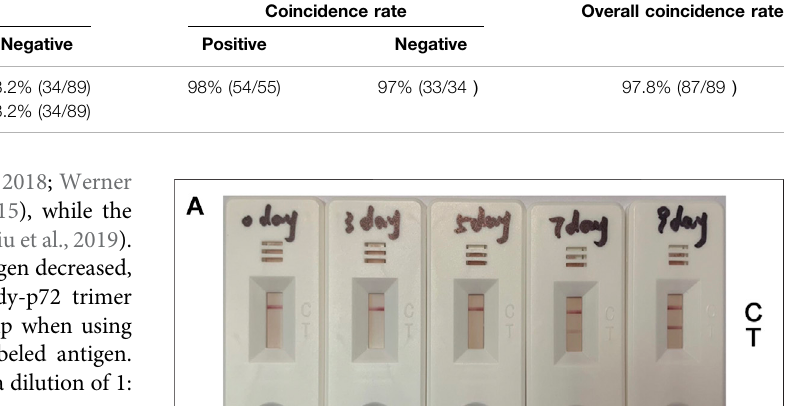
TABLE 1 | Results of the lateral fl ow assay and commercial ELISA. Assay